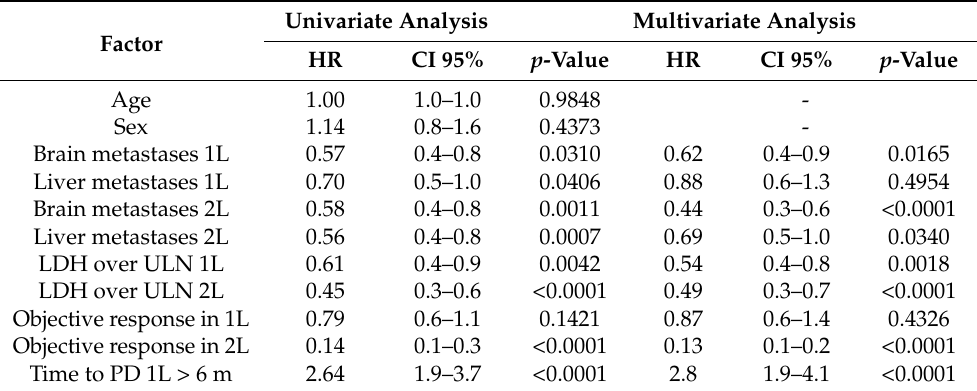
Table 4. Factors that influence OS in metastatic melanoma patients treated with BRAFi/MEKi -> immunotherapy—treatment sequence.